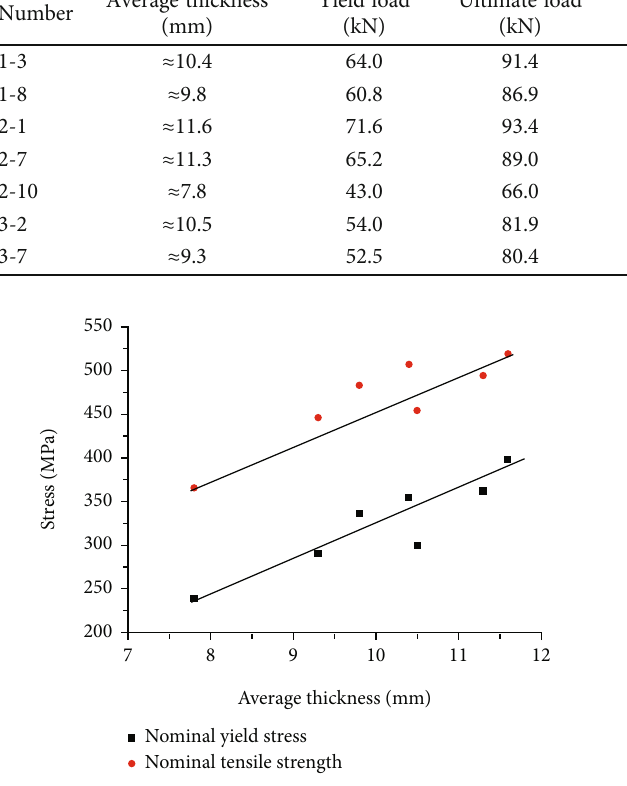
Figure 13: Nominal yield stress and tensile strength of specimens with the average thickness of specimens.